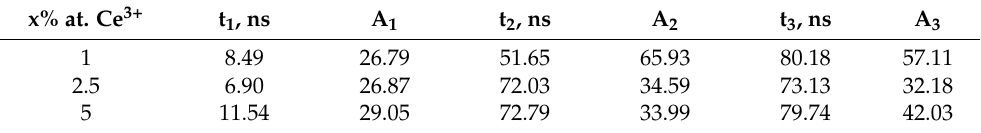
Table 3. Parameters of three exponential approximations of the decay curves presented in Figure 6b (Em = 570 nm, Ex = 450